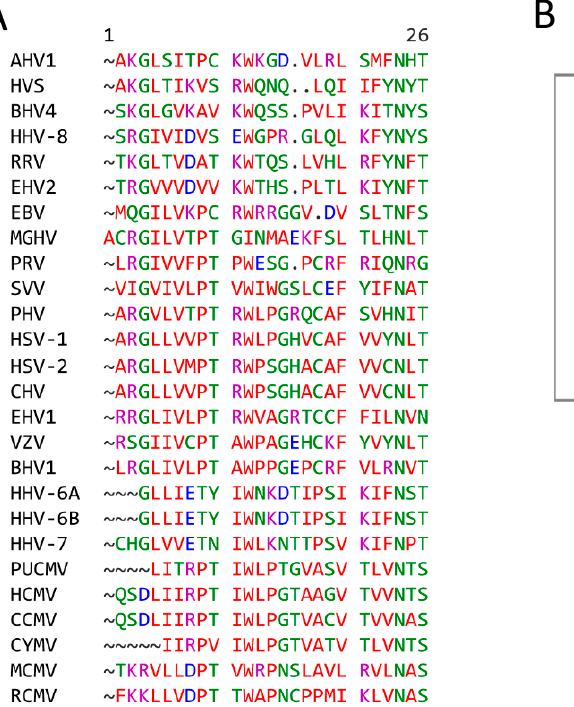
Figure 2. Motif VI of members of the Herpesvirales . ( A ) CLUSTAL OMEGA multisequence alignment of herpesvirus dUTPase Motif IV (Genebank accession code and amino acid (aa) length of motif VI)